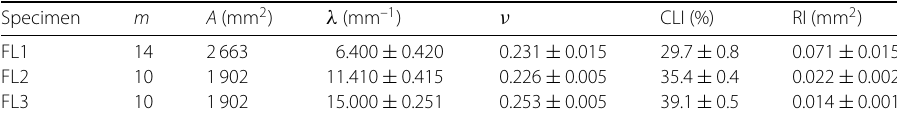
structure. For example, for sample FL2 from Fig. 10, the cloudiness index is 17.1 % for the (i.e. for directions ϕ close to the processing direction of the nonwoven) and sector | ϕ | ≤ π 4 45.5 % for | ϕ | > π 4